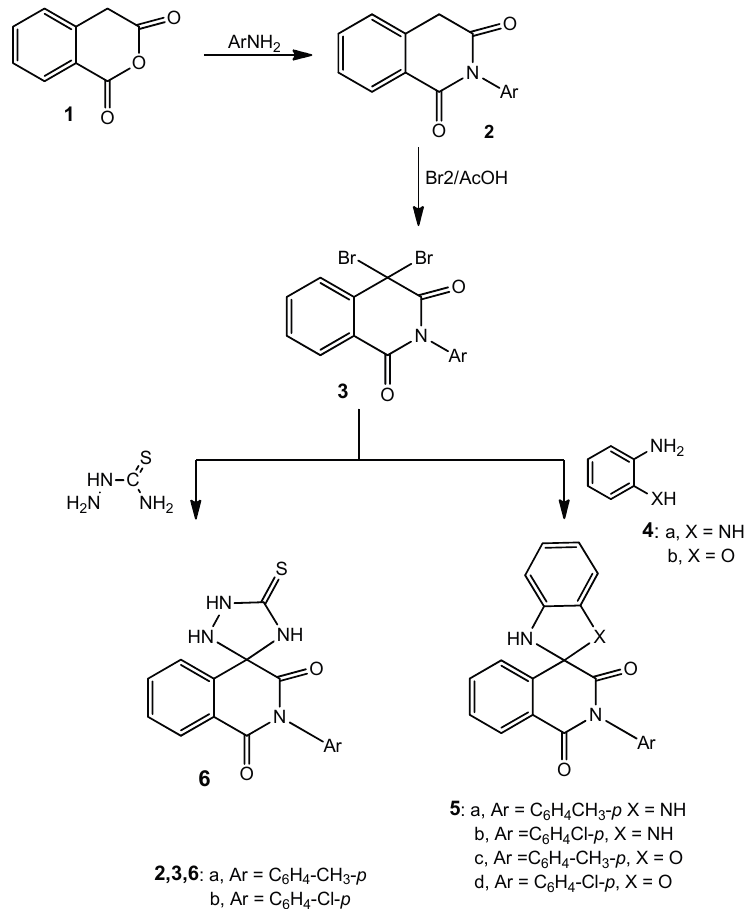
Scheme 1. Reactions of dibromohomophthalimides with binucleophilic reagents: synthesis of 5 and 6